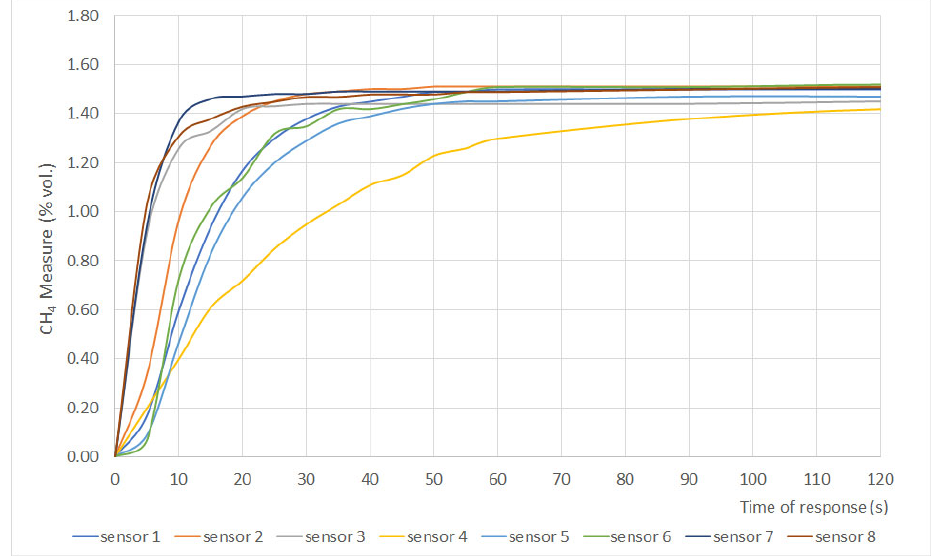
Figure 2. Time of response for sensors 1 to 8.